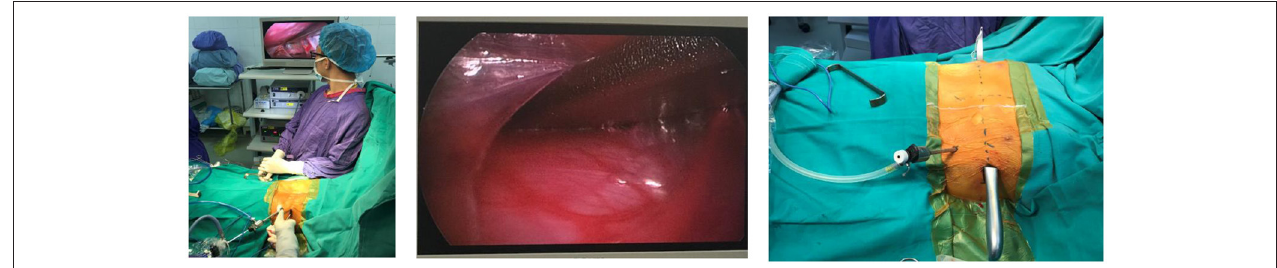
FIGURE 1 | Process of the created tunnel through mediastinum under the control of